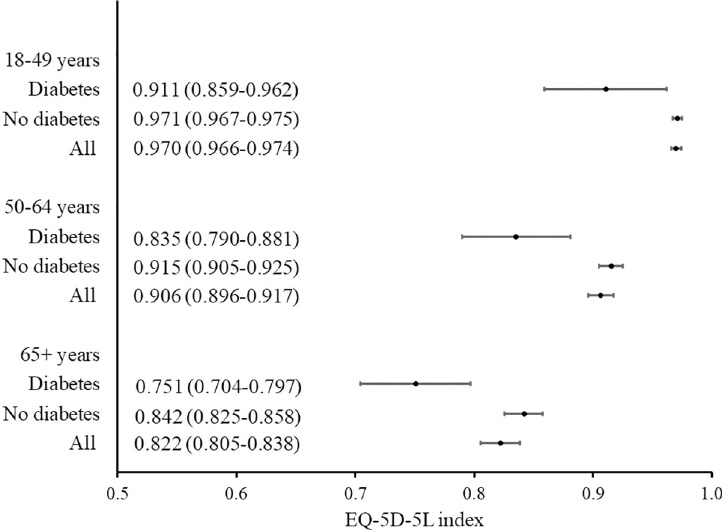
Fig 1. EQ-5D-5L index (mean, 95% confidence interval) according to age group: Comparison of respondents with diabetes versus no diabetes and the general population.